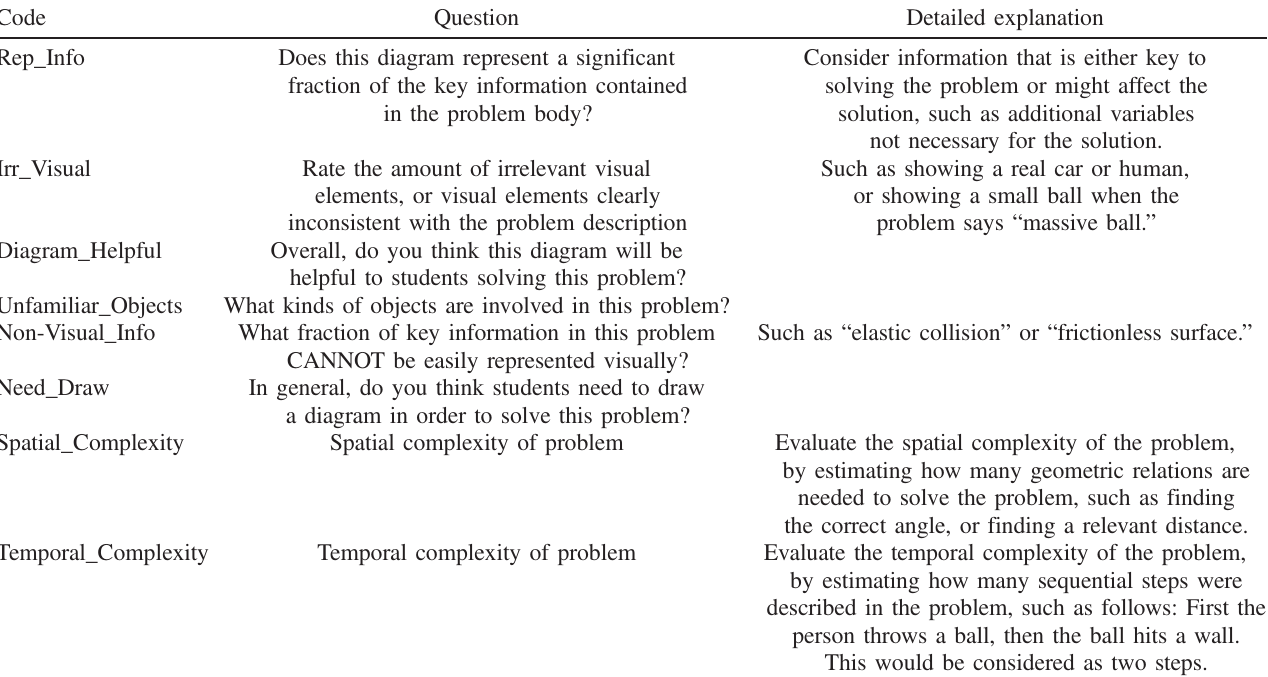
TABLE III. Rating rubric for problem-diagram